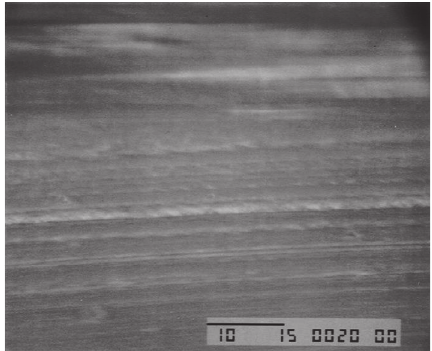
Figure 8: Cross-sectional SEM of a CeO 2 /MMT nanocomposite electrodeposited film using potentiostatic conditions at 𝐸 = 1.10V and 25 ∘ C (bar represents 10 𝜇 m).